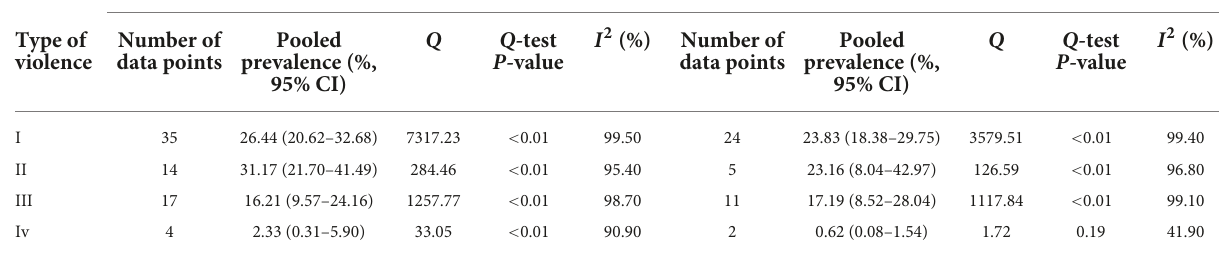
TABLE 2 Pooled estimate of prevalence of